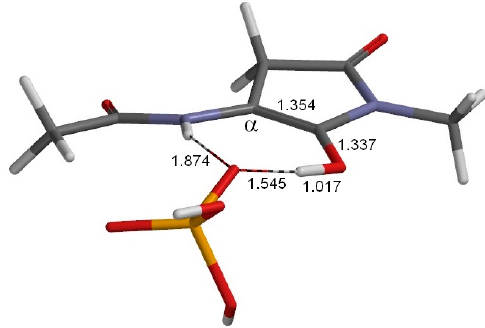
Figure 6. The geometry of the second transition state TS2 ( φ = − 160°, ψ = − 176°, χ 1 = 176°). This transition state connects EN1 (Figure 5) and EN2 (Figure 7), and is for an OH rotation in the H 2 PO 4 − ion of the enol-H 2 PO 4 − complex. Selected interatomic distances are shown in Å. The imaginary frequency of this transition state is 131i cm − 1 . Grey: carbon; white: hydrogen; blue: nitrogen; red: oxygen; orange: phosphorus.